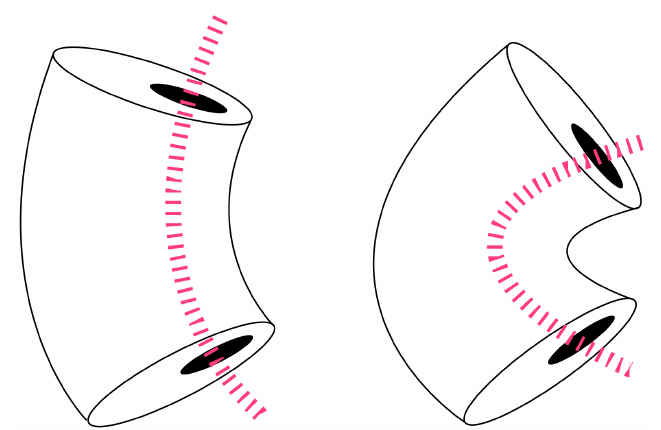
Figure 14. Visualisation of active fibre behaviour in dry ( left ) and damp ( right ) conditions. The antagonistic forces created between the Nylon 6 (N6), which elongates in damp conditions and the sti ff , hydrophobic polypropylene (PP) cause the fibre to bend, defined as an increase in angel of crimp in the textile industry. Table 1. Overview of cross section design and polymer combinations applied to the development of fibre samples. Key: AQ55s (Ethlylcellulose), N6 (Nylon 6), PET (Polyester), PP (Polypropylene), ESC (eccentric sheath core), SXS (side by side). Ratio. Composition Cross Section 50 / 50 N6 PP ESC N6